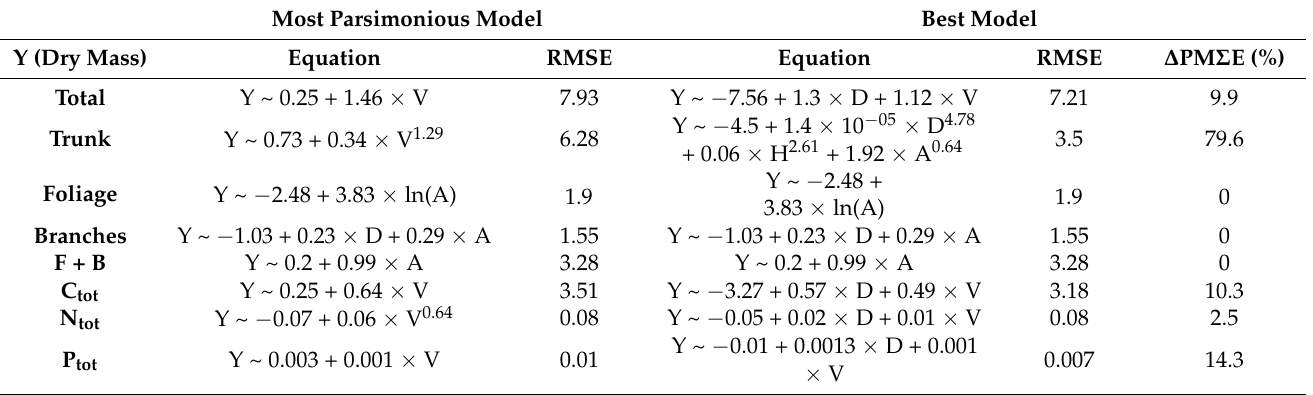
Table 3. Most parsimonious and best fit models for various dependent variables of single trees. H = height (m), A = area (m 2 ), V = volume (m 3 ), and D = diameter at soil height (cm). RMSE = root mean square error, C tot = total carbon, N tot = total nitrogen, P tot = total phosphorus, and